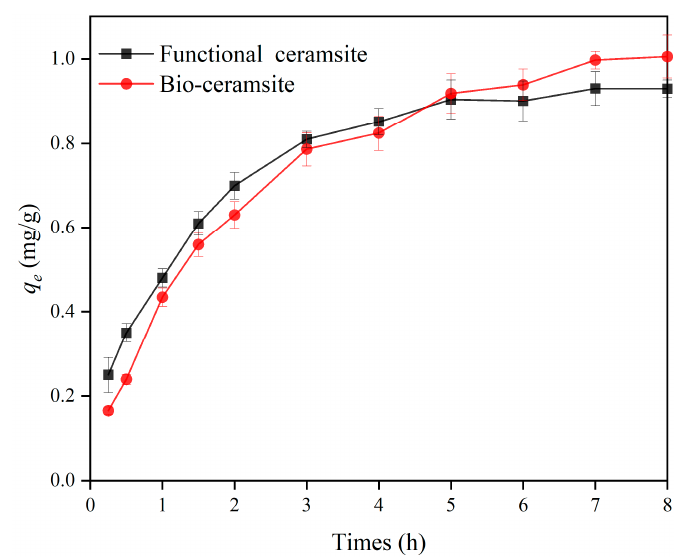
Figure 6. A comparison of ammonium adsorption capacity between bio-ceramsite and functional ceramsite.